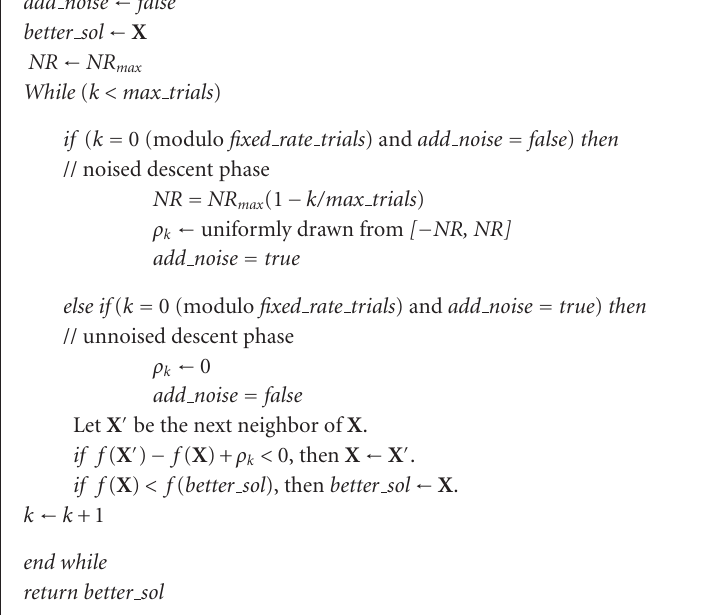
Algorithm 3 . 2 . Pseudocodes for local search using noising